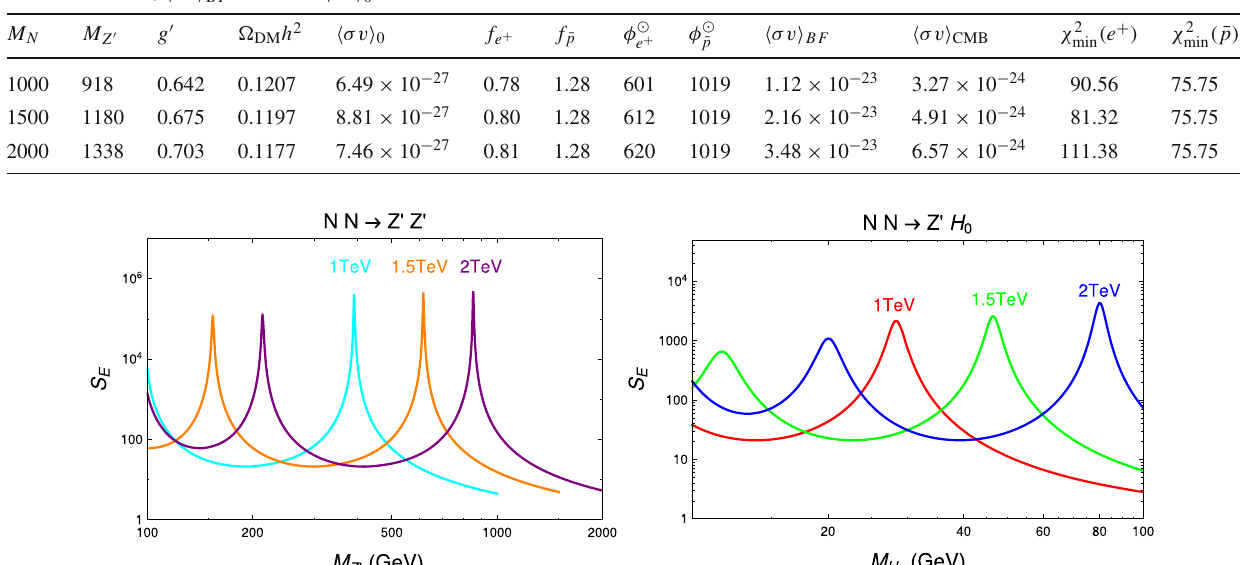
(right) for the benchmark 0